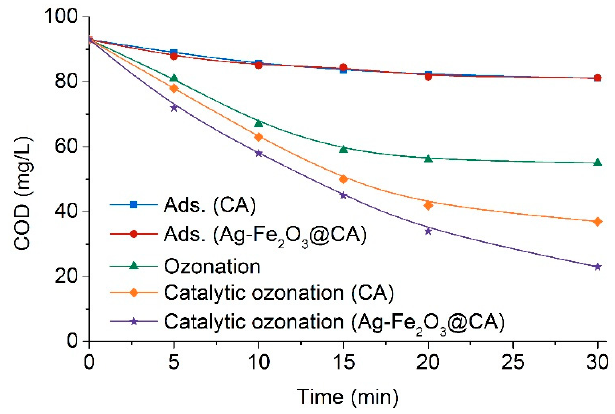
Figure 11. COD of the Effluent 1 treated by various processes.